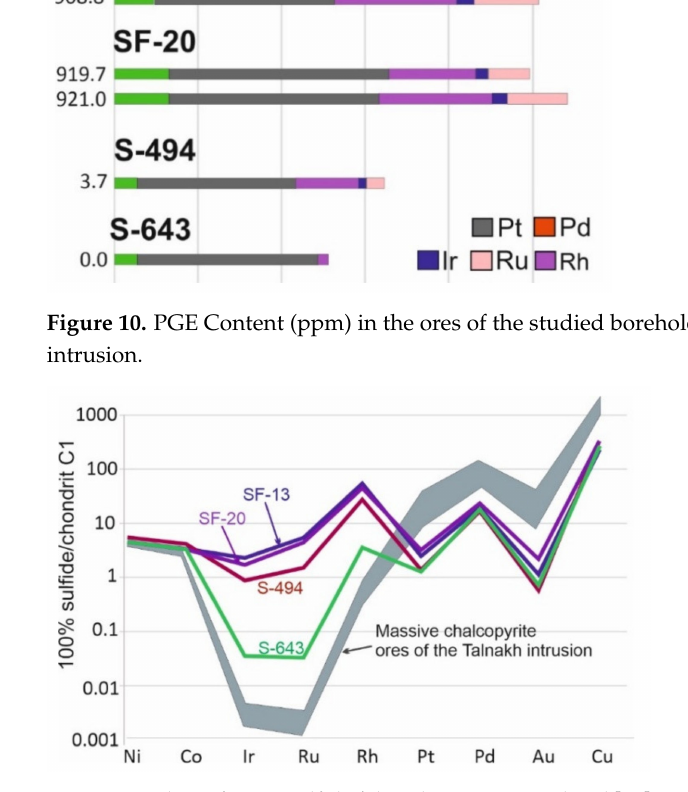
Figure 11. Plots of 100% sulfide/chondrite C1-normalized [40] average tenors of chalcophile elements in massive ores. Gray area—massive chalcopyrite ore of the Talnakh intrusion, Southern-2 orebody (Yz-5 and Yuz-12 samples)